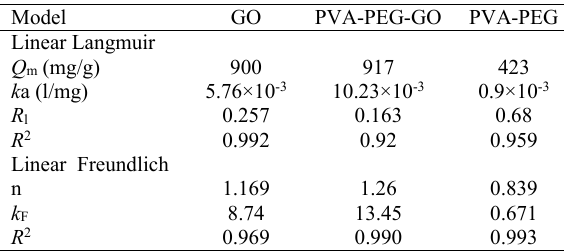
Table 2: Fitting parameters for Langmuir and Freundlich isotherms